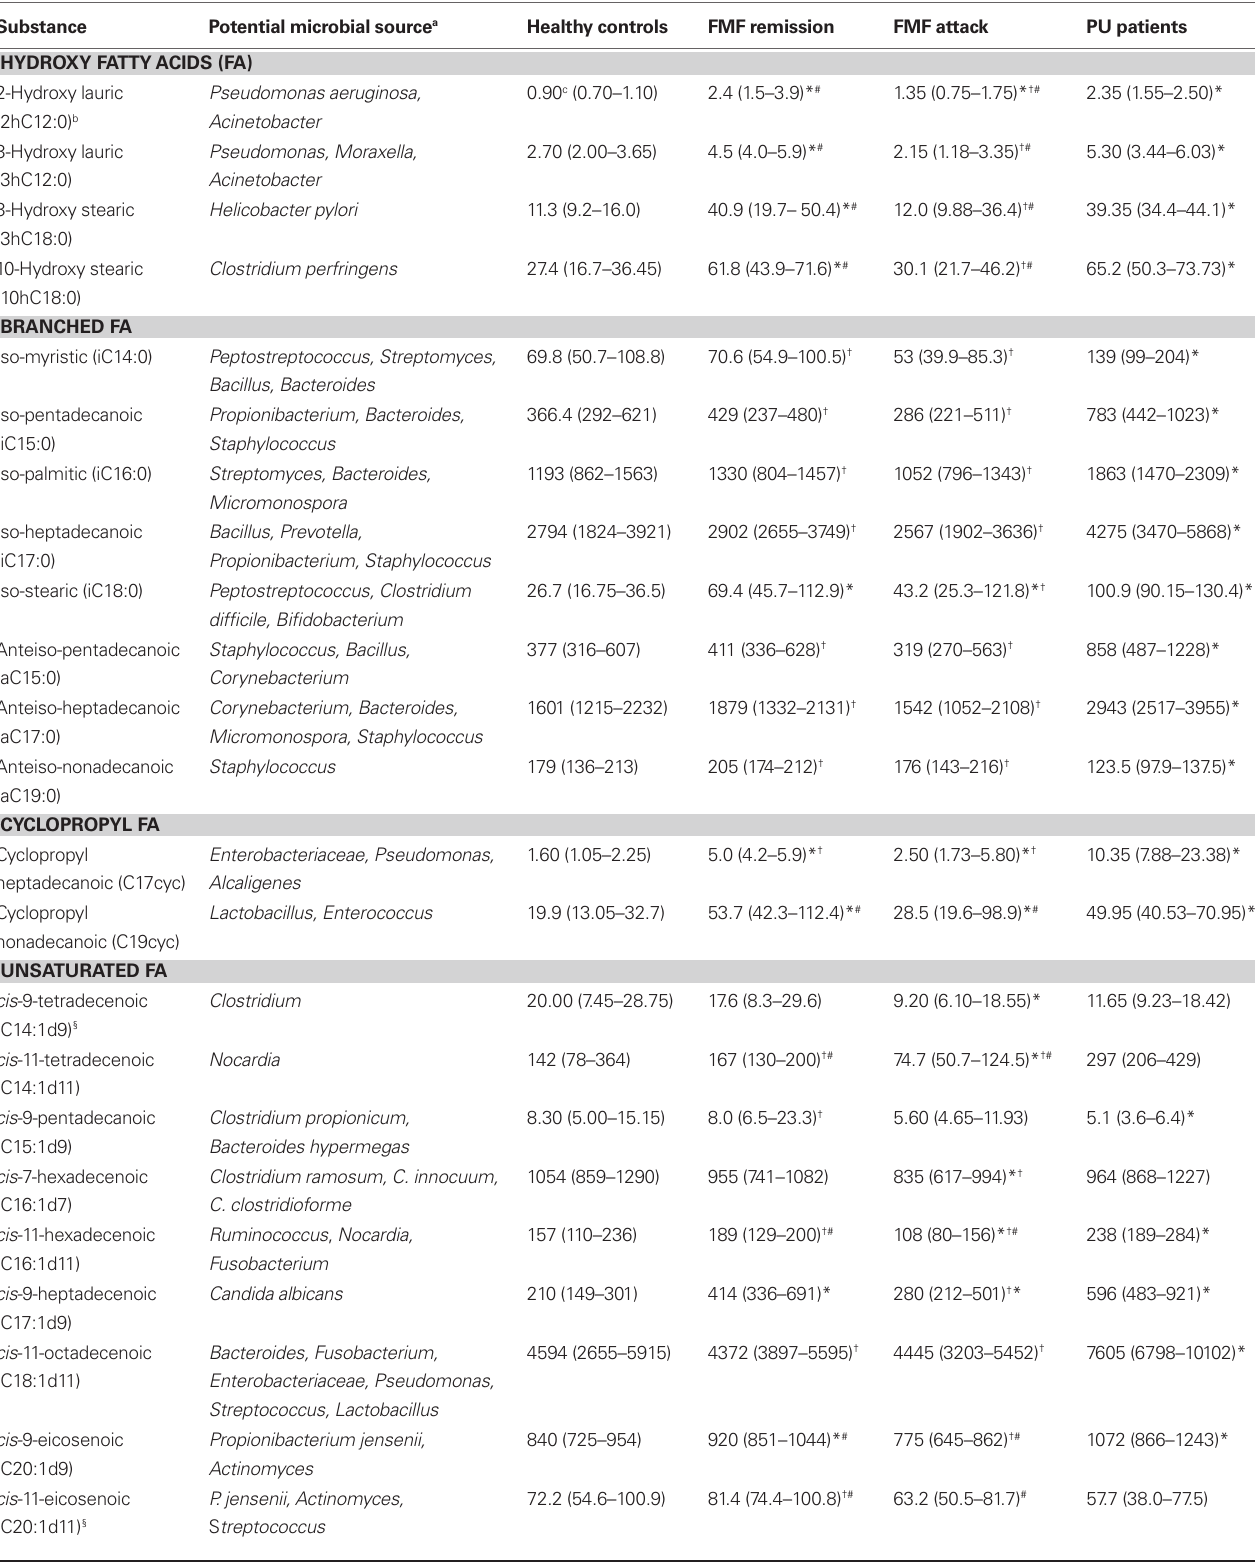
Table 1 | Concentration of compounds and their potential microbial source in blood of FMF and PU patients and healthy controls. Substance Potential microbial source a Healthy controls FMF remission FMF attack PU